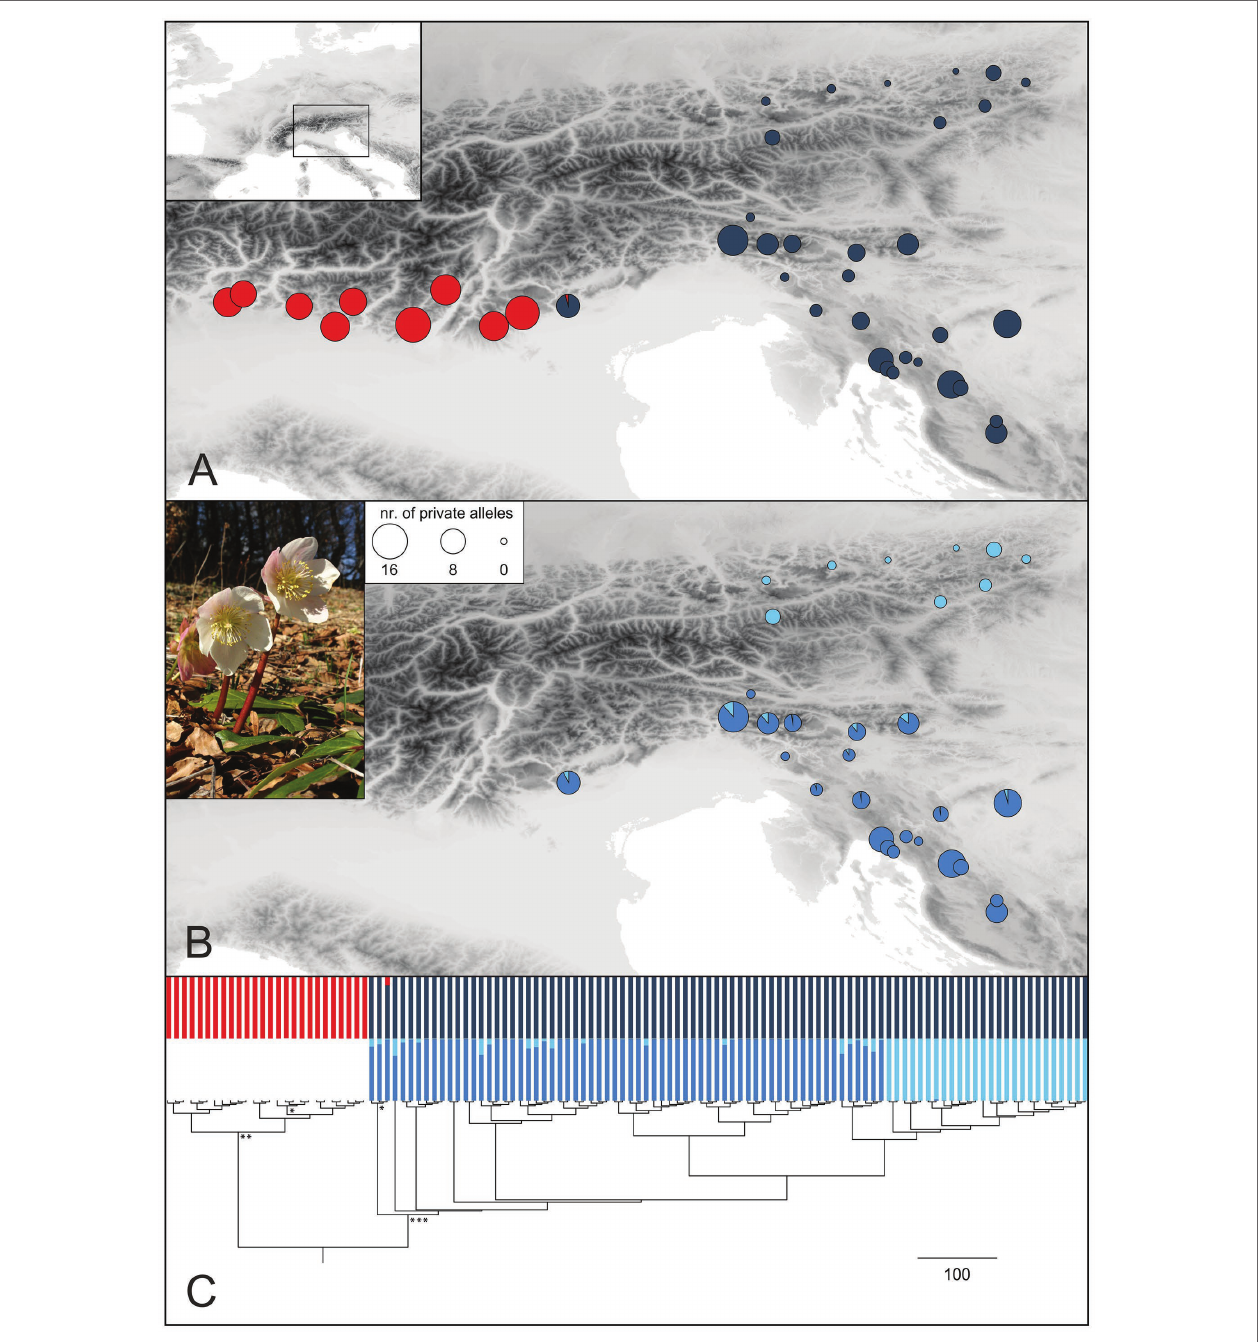
FIGURE 3 | Genetic structure in H. niger (pictured) based on RADseq. (A) STRUCTURE analysis of the entire RADseq dataset yielded two groups (cluster memberships were summarized for all analyzed individuals per population; red, Western Group; blue, Eastern Group) as optimal solution. Sizes of pie charts reflect the number of private alleles in each population. (B) Subclusters (middle blue, South-Eastern Subgroup; light blue, North-Eastern Subgroup) as identified by STRUCTURE analysis of the Eastern Group. (C) Phylogenetic analysis conducted with RaxML; the outgroup Helleborus foetidus is not shown. Bootstrap support (BS) of major clades is indicated by asterisks ( * , 74% BS; ** , 87% BS; *** , 96% BS); a tree with labeled terminals and bootstrap support values is presented in Supplementary Figure 5 . The tree is complemented with barplot representations of the STRUCTURE results shown in (A,B)